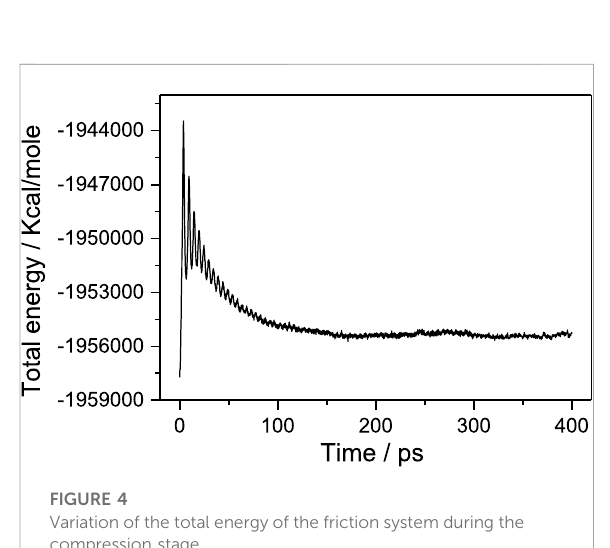
Variation of the total energy of the friction system during the compression stage.